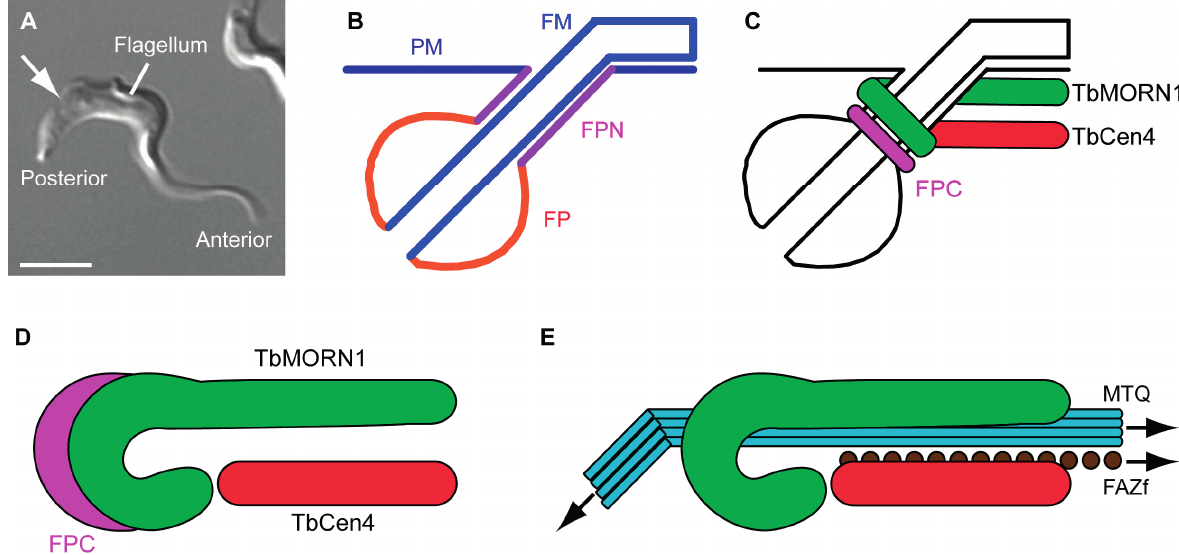
Figure 1. Membrane subdomains and the morphology of the TbMORN1-containing complex. ( A ) A BSF T. brucei cell. The anterior and posterior ends of the cell, and the single flagellum, are labelled. The approximate point where the flagellum enters the cell body is indicated (arrow). Scale bar, 5 µm; ( B ) Schematic showing membrane subdomains in the region of the flagellar pocket. The plasma membrane (PM), flagellar pocket neck (FPN), flagellar pocket (FP), and flagellar membrane (FM) are composed of one continuous lipid bilayer but constitute four distinct morphological subdomains; ( C ) Schematic showing the position of the flagellar pocket collar (FPC) and the inferred positions of the multiprotein complexes containing TbMORN1 and TbCentrin4 in the region of the FPN; ( D ) Schematic showing the FPC, TbMORN1, and TbCentrin4 in a “top down” orientation. Colour scheme same as in part C; ( E ) Schematic showing the position of TbMORN1 and TbCentrin4 relative to the cytoplasmic components of the flagellum attachment zone (FAZ). These FAZ components are termed the microtubule quartet (MTQ) and FAZ filament (FAZf). For clarity, the flagellum and FPC have been